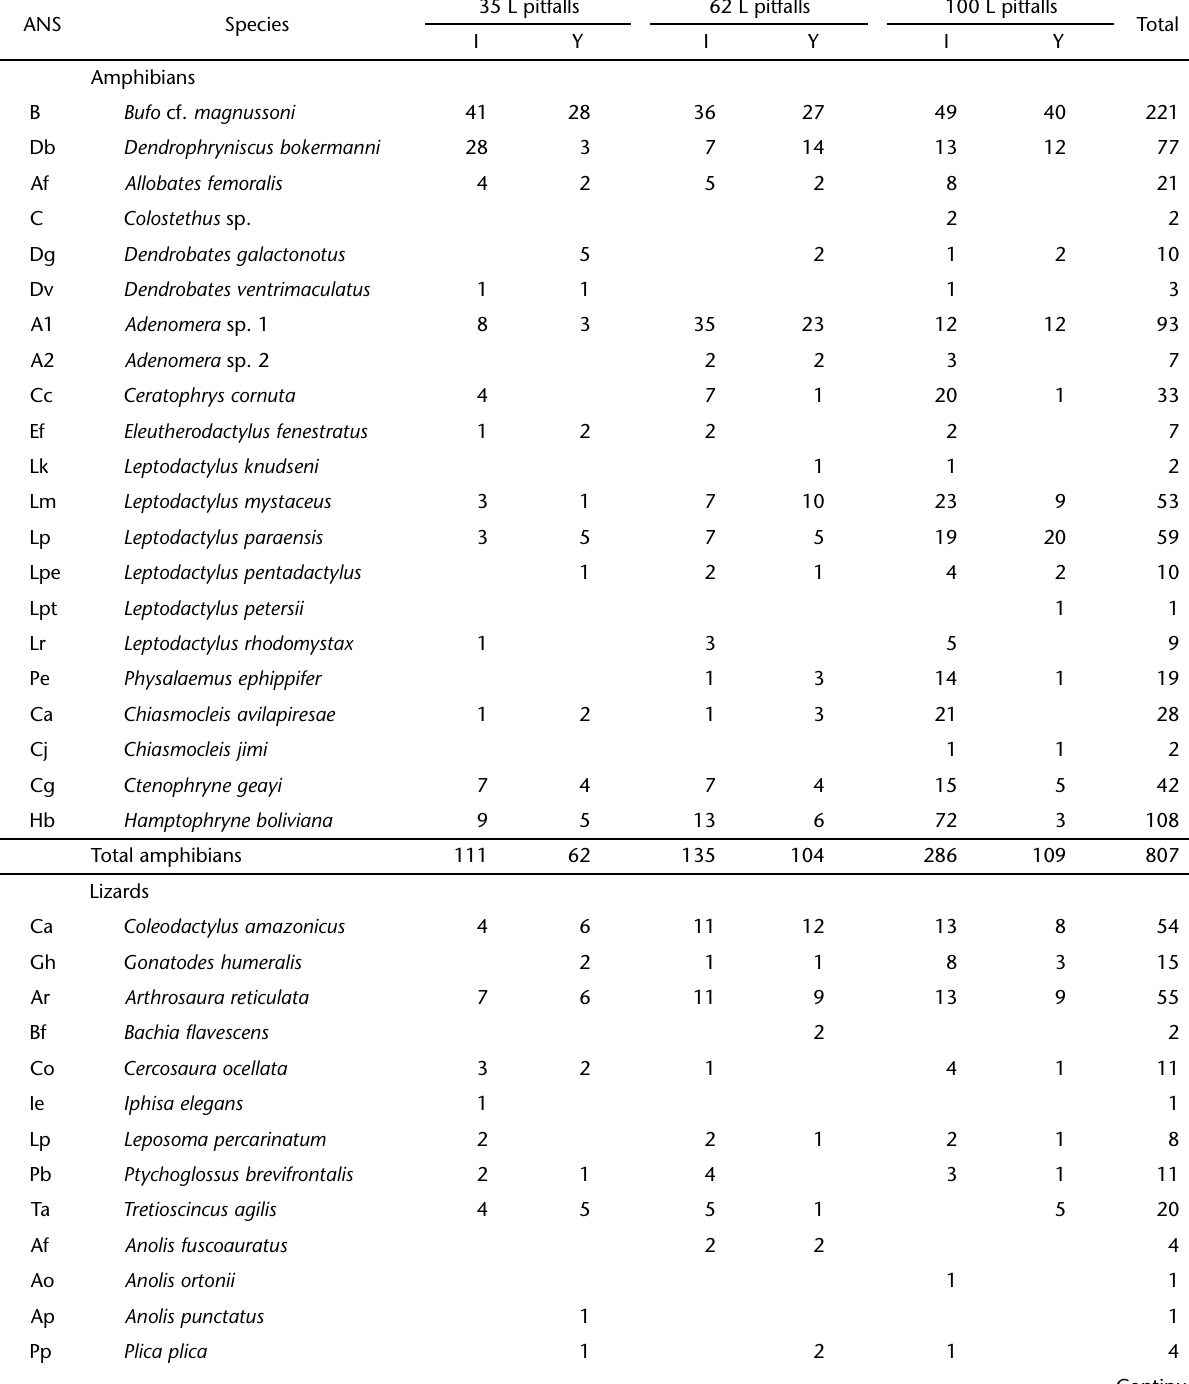
Table I. Species and number of individuals of leaf litter amphibians, lizards, snakes and small mammals captured by different pitfall trap types in the PPBio research site of the Floresta Nacional de Caxiuanã, Brazilian Amazon. (I) Pitfall traps with line design, (Y) pitfall traps with Y design, (ANS) abbreviation of species names used in figures 5 and